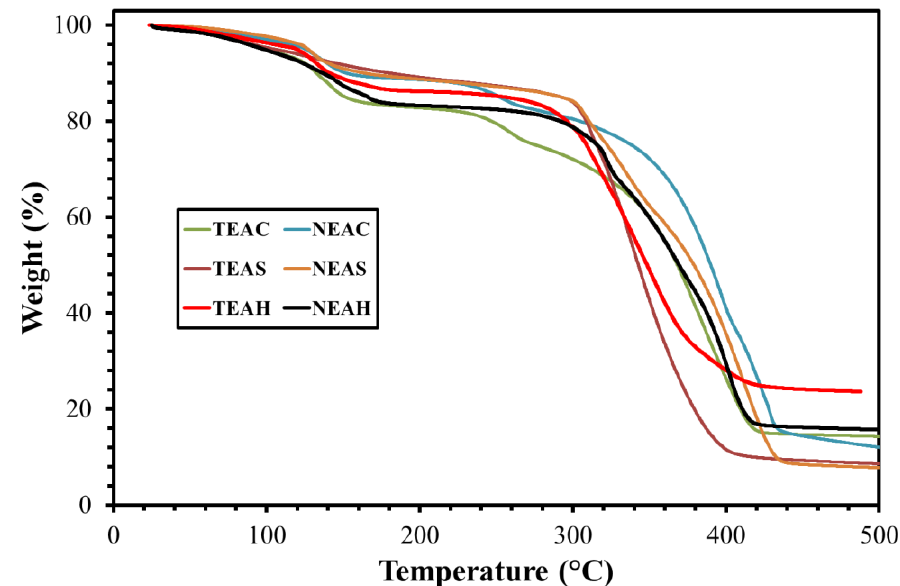
Figure 7. Thermal Gravimetric Analysis (TGA) curves of zwitterionic surfactants.